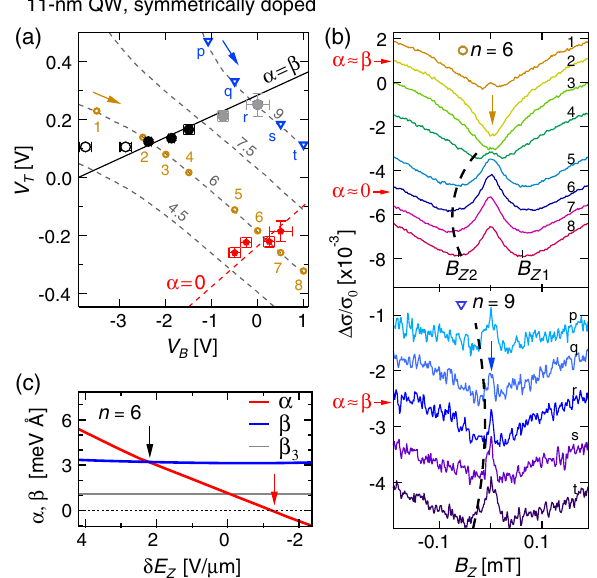
FIG. 4. The Dresselhaus and the cubic regime. (a) Locked regime α ≈ β (black or gray symbols) and Dresselhaus regime α ≈ 0 (red symbols) from the broadest WAL minima (maximal B ) in the V and V plane for a more symmetrically doped T B SO 11-nm well. The solid black line displays the α ¼ β simulation, while the dashed red line marks the simulated α ¼ 0 contour. Open black markers (leftmost V ) are entering the nonlinear gate B regime, causing a slight deviation from theory, which assumes linear gate action. The rightmost V points (gray) are obtained B from the minimal B in the presence of WAL. (b) Sequence at SO n ¼ 6 × 10 11 cm − 2 (upper panel) and n ¼ 9 × 10 11 cm − 2 (lower panel), shifted vertically for clarity. Each brown or blue marker in (a) corresponds to a trace in (b), as labeled by numerals or letters. B is indicated as a guide for the eye by black dashed curves for SO negative B . B increases and peaks (indicating α ¼ 0 ) before Z SO decreasing again (upper panel). Broken spin symmetry regime (lower panel): WAL is no longer suppressed here due to symmetry breaking from the cubic term at large n . Still, α ≈ β can be identified with the narrowest WAL peak. (c) Simulation of α and β along n ¼ 6 × 10 11 cm − 2 . α traverses both β (black arrow) and for smaller δ E also zero (red Z